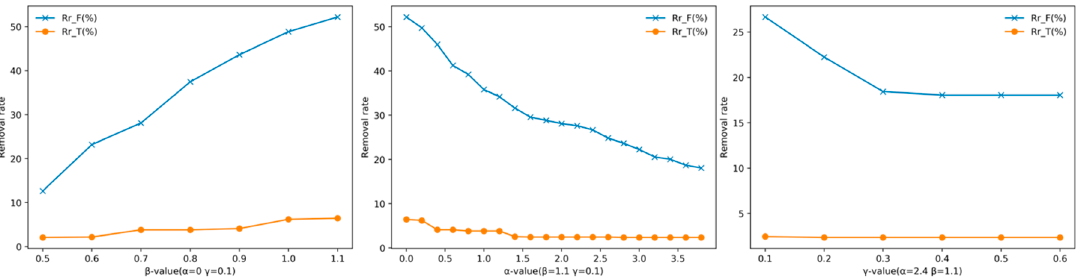
ff erent β , α and γ values. Sensors 2019 , 19 , x FOR PEER REVIEW